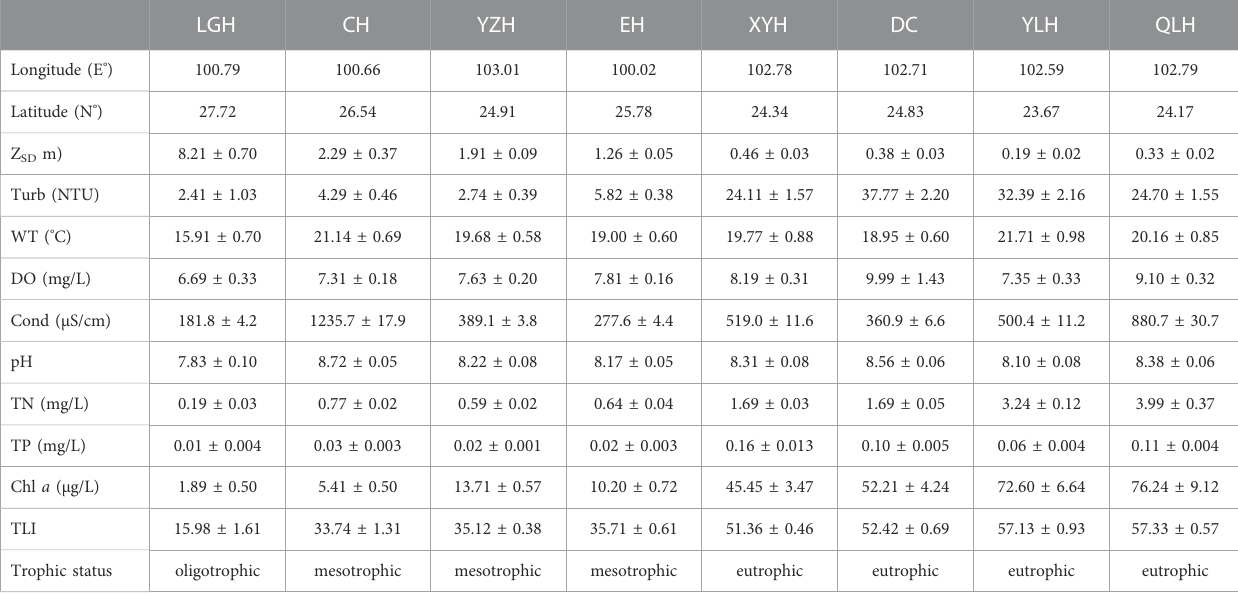
TABLE 1 Main limnological characteristics (mean ± SE) of the eight studied lakes. LGH CH YZH EH XYH DC